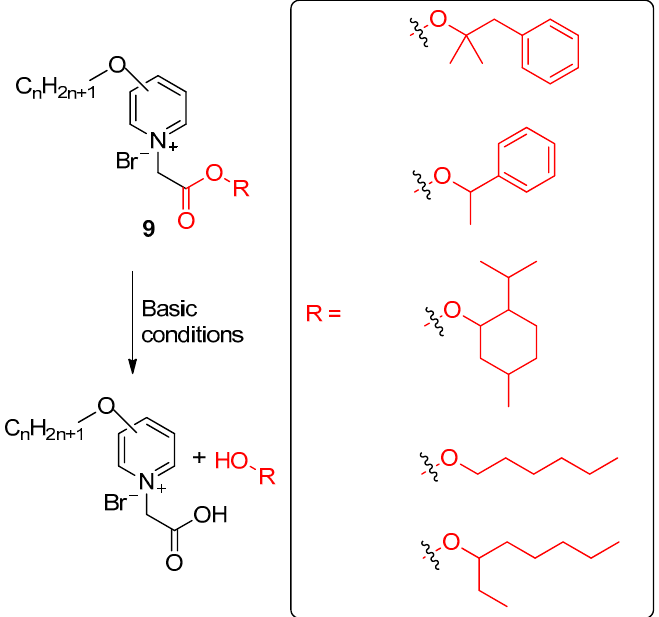
Figure 11. Release of alcohol-based scents from quaternary pyridinium surfactants profragrances 9 , highlighting the precursor of the scent. The fragments of the scents are included in a box. The original results were reported by Han, Zhu and coworkers [96].